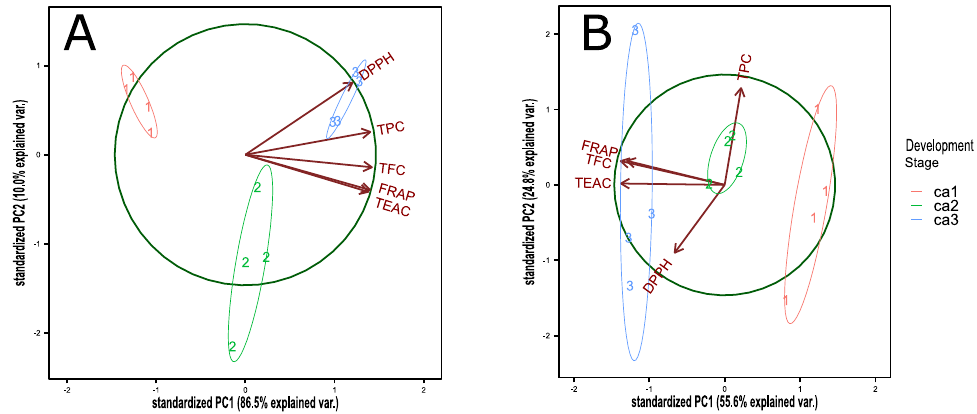
Figure A1. PCA biplot for antioxidant indices in the three development stages of peumo fruit of two harvest seasons, 2017 ( A ) and 2018 ( B ).